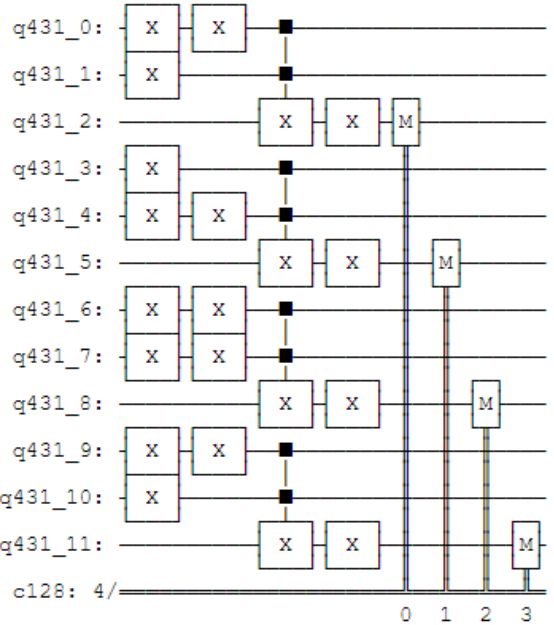
Figure 15. Classical OR gate using the Pauli-X and Toffoli gates.